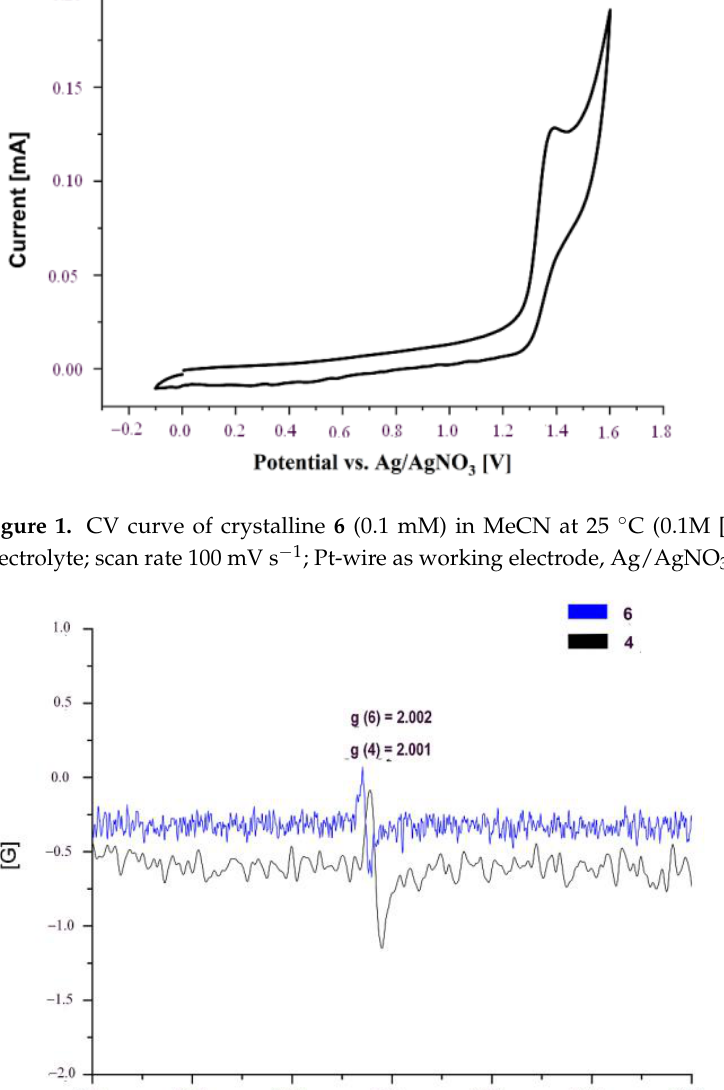
Figure 2. EPR spectra of compounds 4 and 6 after being subjected to sunlight.